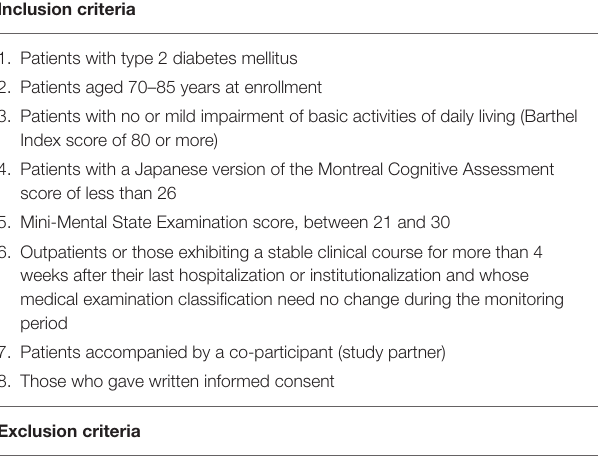
TABLE 1 | Inclusion and exclusion criteria for the J-MIND-Diabetes trial. Inclusion